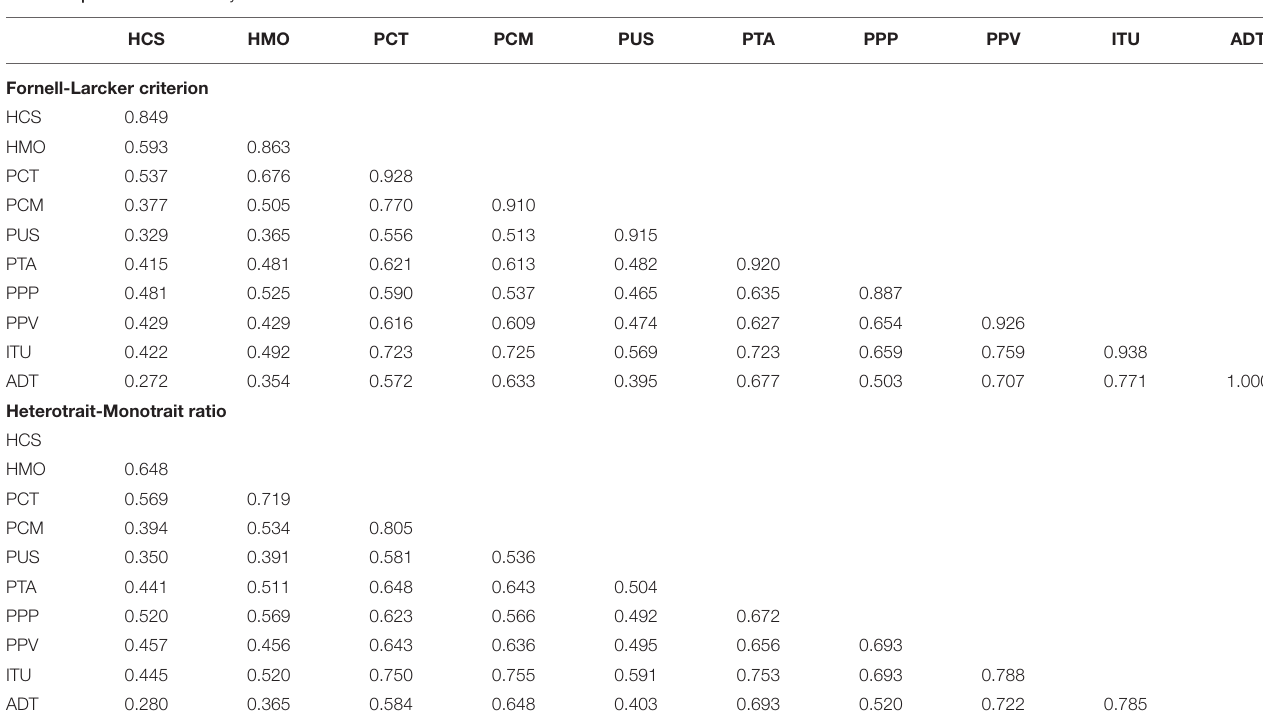
TABLE 3 | Discriminant